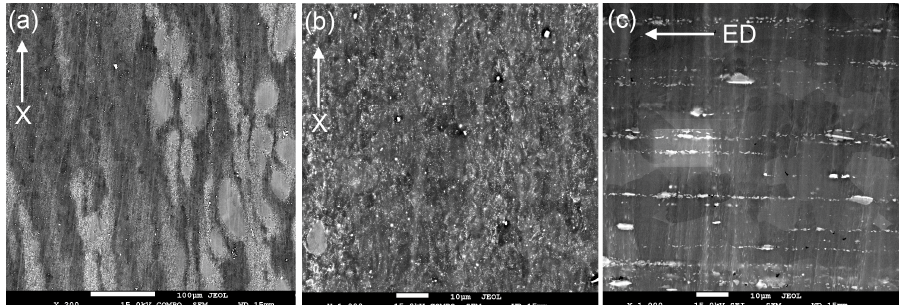
Figure 2. Scanning electron microscope (SEM) images showing the microstructure of the alloy ZK60 ( a ) and ( b ) and WZ21 ( c ) corresponding to the same specimens, as shown in Figure 1a,b—ZK60 MIF- processed through one step at 400 °C and two-steps at 400 °C and 300 °C, respectively, and Figure 1c—the hot extruded alloy WZ21. Arrows indicate the working direction: X on ( a ) and ( b ) denotes the longitudinal direction of multi-axial isothermal forging (MIF) (see [27] for details) and ED on ( c ) corresponds to the extrusion direction.